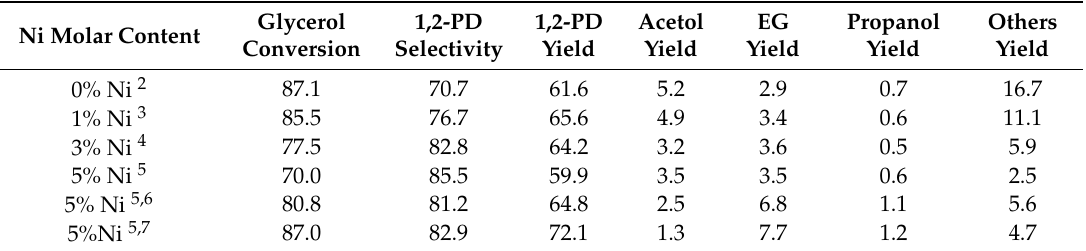
Table 4. Products distribution for glycerol hydrogenolysis with in situ H 2 from methanol steam reforming over Cu / ZnO / Al 2 O 3 -OA catalysts with di ff erent Ni loading 1 . Glycerol 1,2-PD 1,2-PD Acetol Ni Molar Content Conversion Selectivity Yield Yield